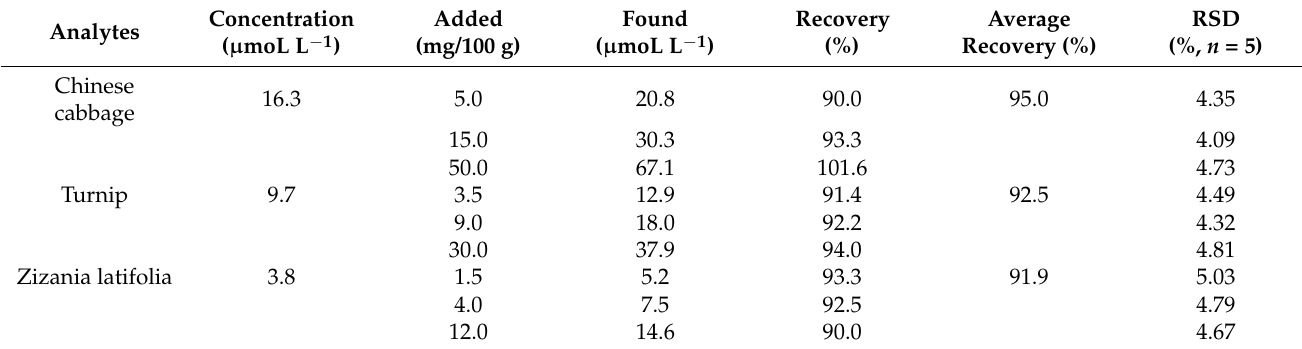
Table 2. Determination of AA in Real